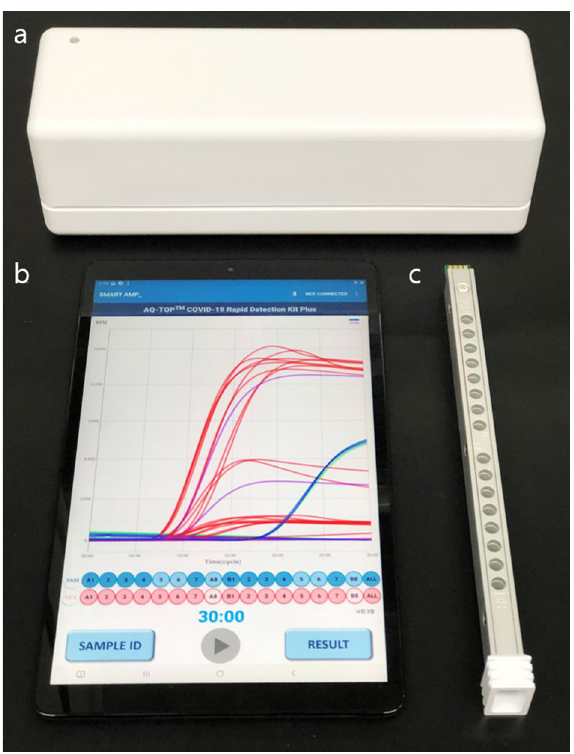
Figure 1. ( a ) A portable isothermal amplifier, ( b ) tablet computer with an operating system and c) 16 well heating plate applicable to the